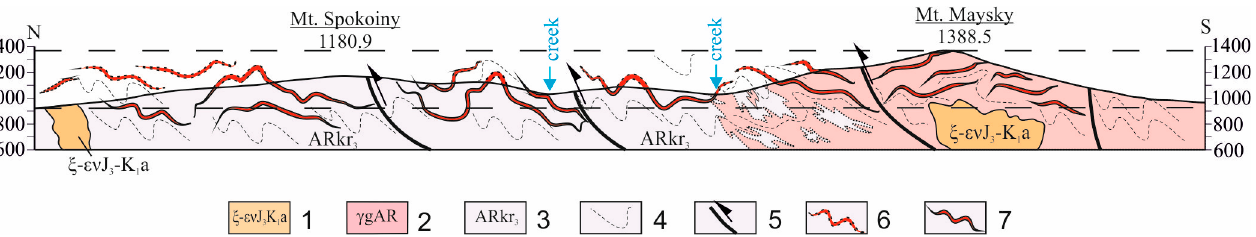
Figure 2. Geological cross section for gold mineralization of the Spokoininsky ore cluster, longitu- dinal section [1] with changes: 1—stocks of alkaline syenites; 2—granitized gneisses and granite gneisses; 3—Kurikan Formation, upper subformation; 4—folds; 5—reverse (to thrust) faults; 6,7—lodes: a—eroded and b—not eroded.